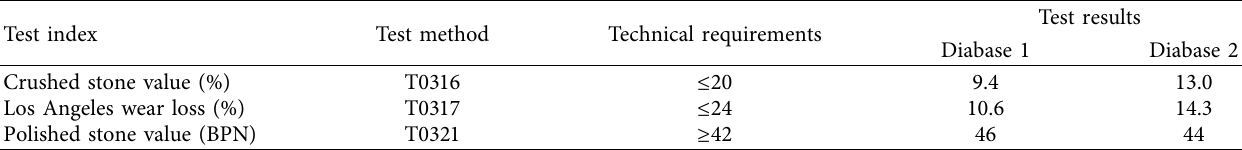
Table 3: Test results of the fine aggregate technical